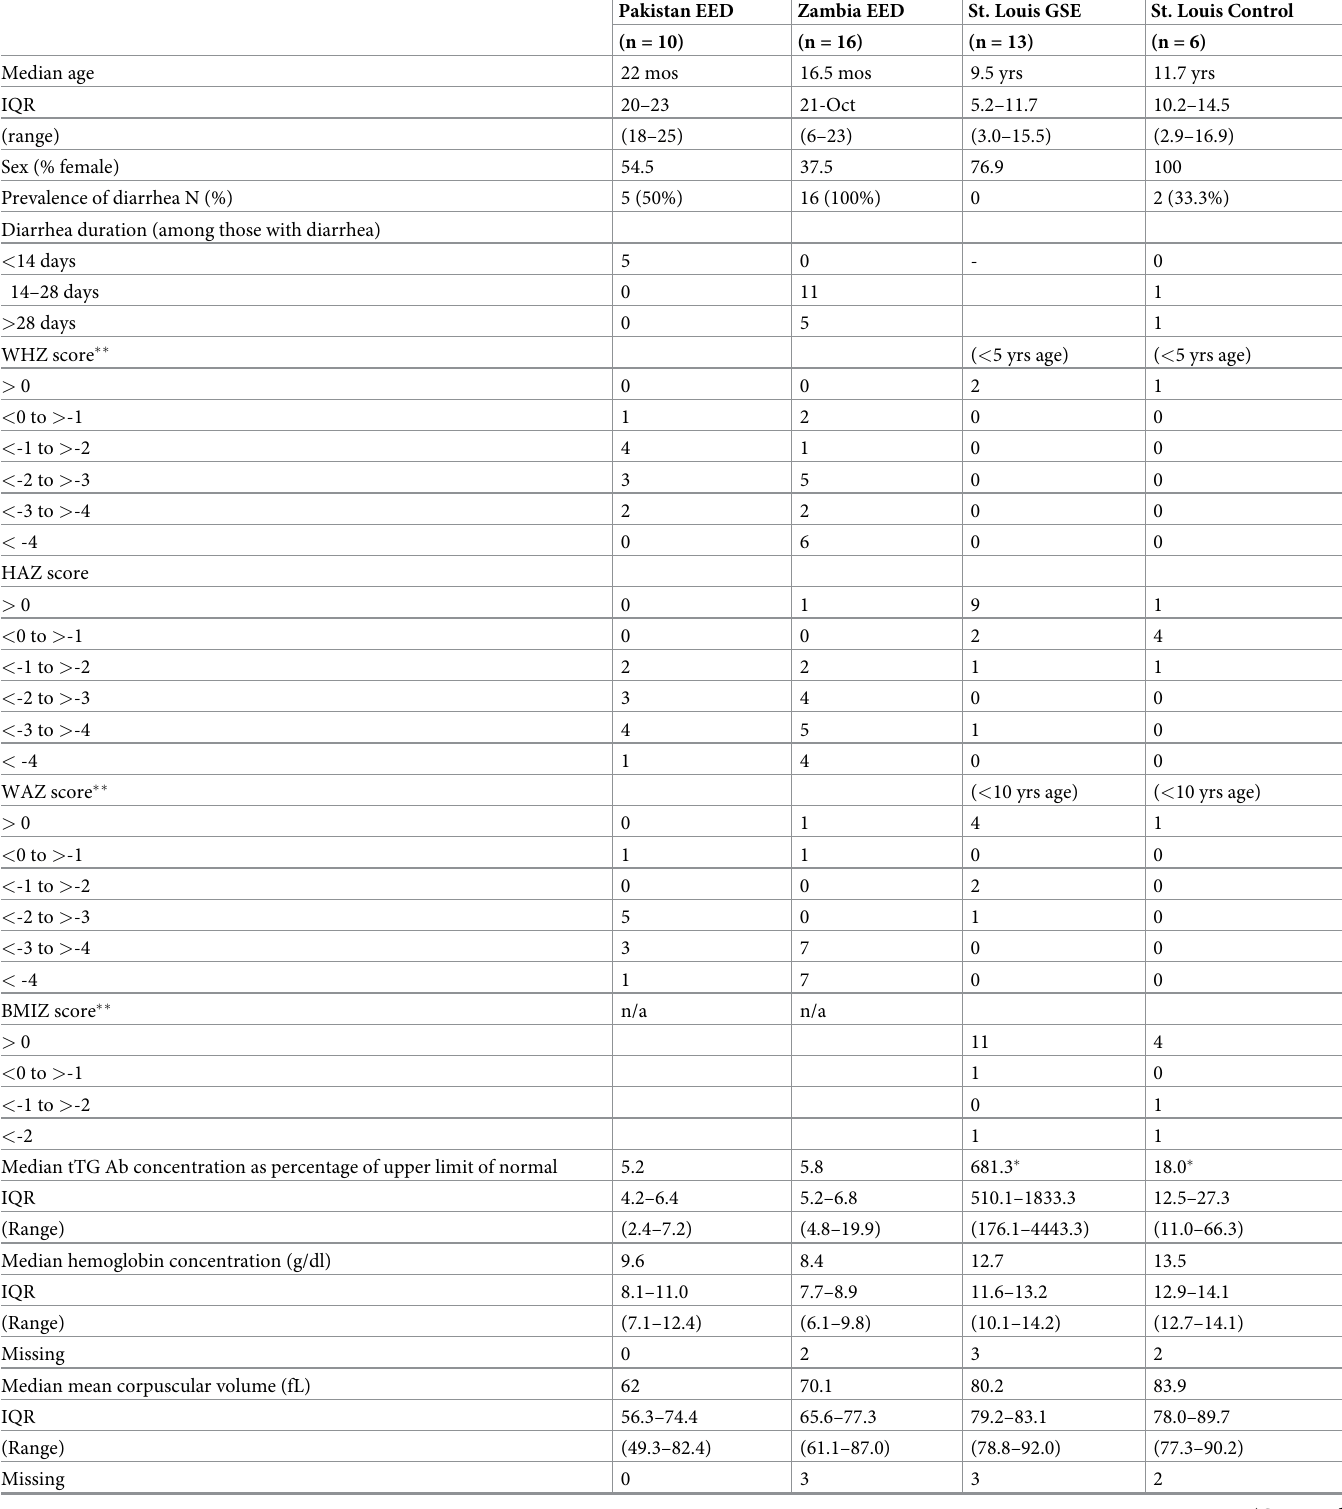
Table 2. Demographics of the study